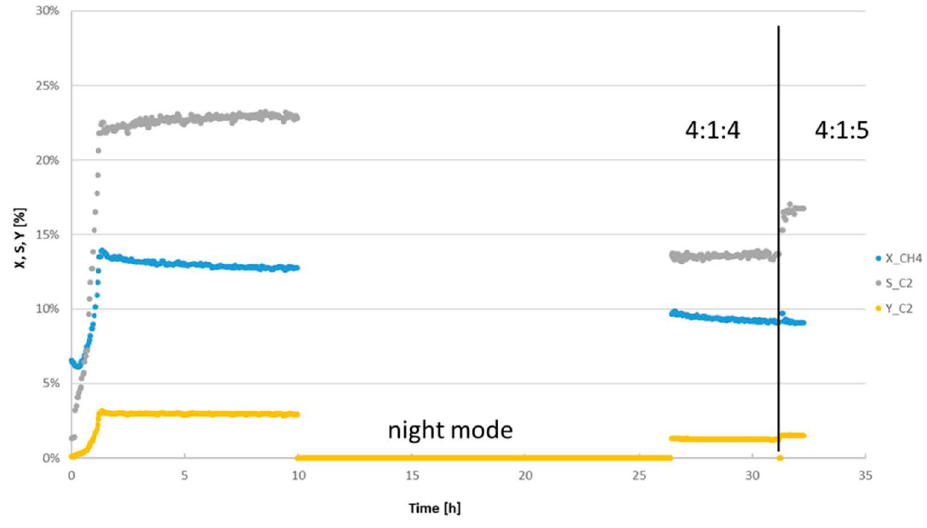
Figure 9. First catalyst charge. Catalyst testing of 3D structured catalyst at 840 ◦ C, GHSV = 4080 mL CH4 g − 1 Cat. h − 1 , CH 4 :O 2 :N 2 = 4:1:4 (later 4:1:5); (legend: X_CH 4 —methane conversion in %, S_C 2 —C 2 -selectivity in %, Y_C 2 —yield of C 2 products in %).